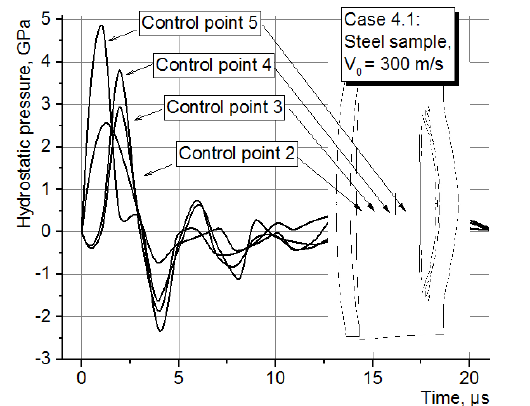
Fig. 6 . FGM-samples after impact at t = 0,20 µs. Gray shade allocated gradient substrate in the sample.